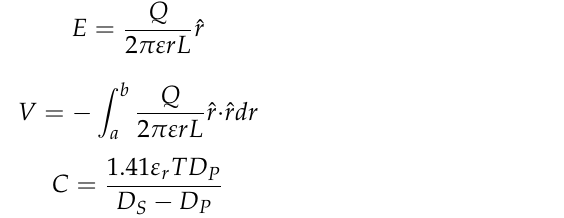
where D S represents the diameter of the clearance circular hole in the ground plane, D p is the diameter of the via-hole pin, h is the thickness of the substrate, and ε r is the relative electric permittivity. All dimensions are expressed in inches. shows the analysis of the via-hole as a function of the thickness of the substrate, T (h 1 + h 2 ) , and circular slot diameter, Ds , towards the value of the capacitance for a via with a fix value of via-hole pin diameter, D p , of 0.3 mm. The results show the thickness, T , and the circular slot diameter, Ds (dimensions in inches), variation affect the value of the via-hole capacitance. The capacitance increases sharply when the ground plane is nearer to the microstrip via.